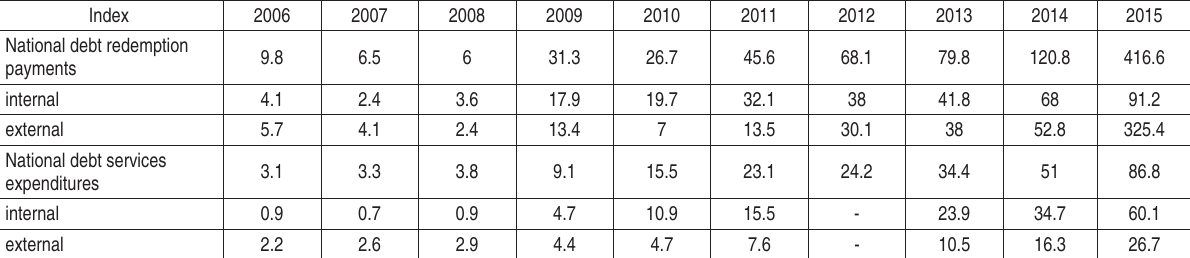
Table 4. The dynamics of national payments for redemption, expenditures and service of IND and END,